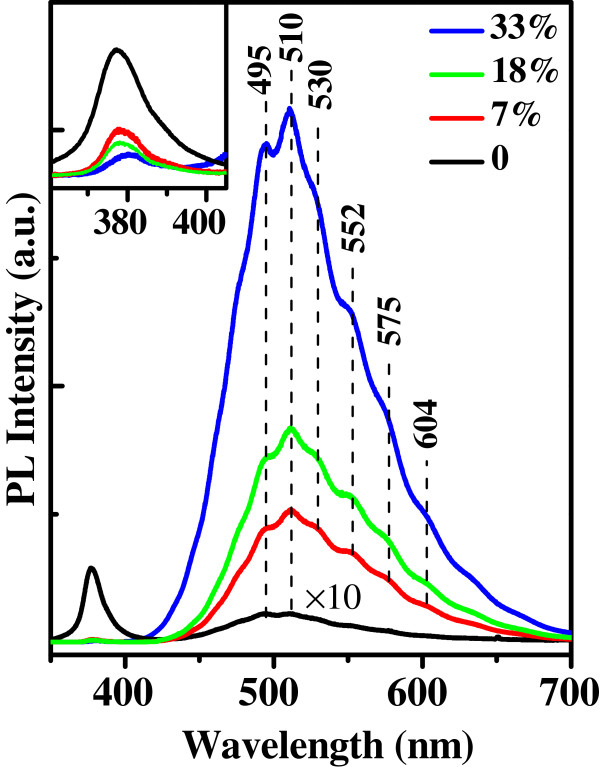
PL spectra. PL spectra of undoped ZnO and Zn1−xCuxO samples with the Cu contents of 7%, 18%, and 33%.